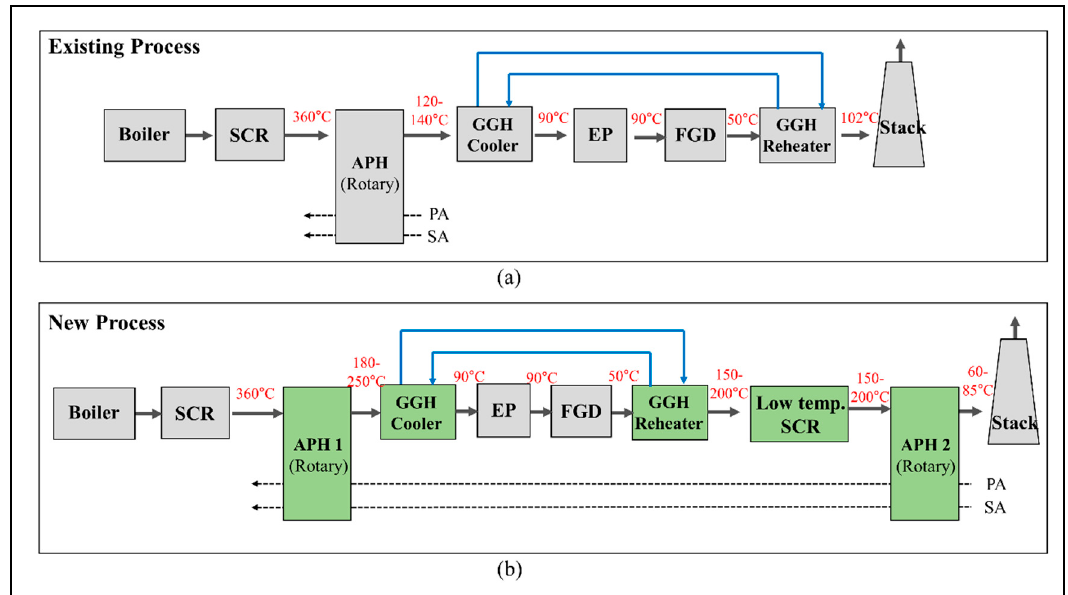
Figure 1. Schematic diagram of the new process for a coal-fired power plant with a low-temperature selective catalytic reduction (SCR): ( a ) existing process and ( b ) new process.